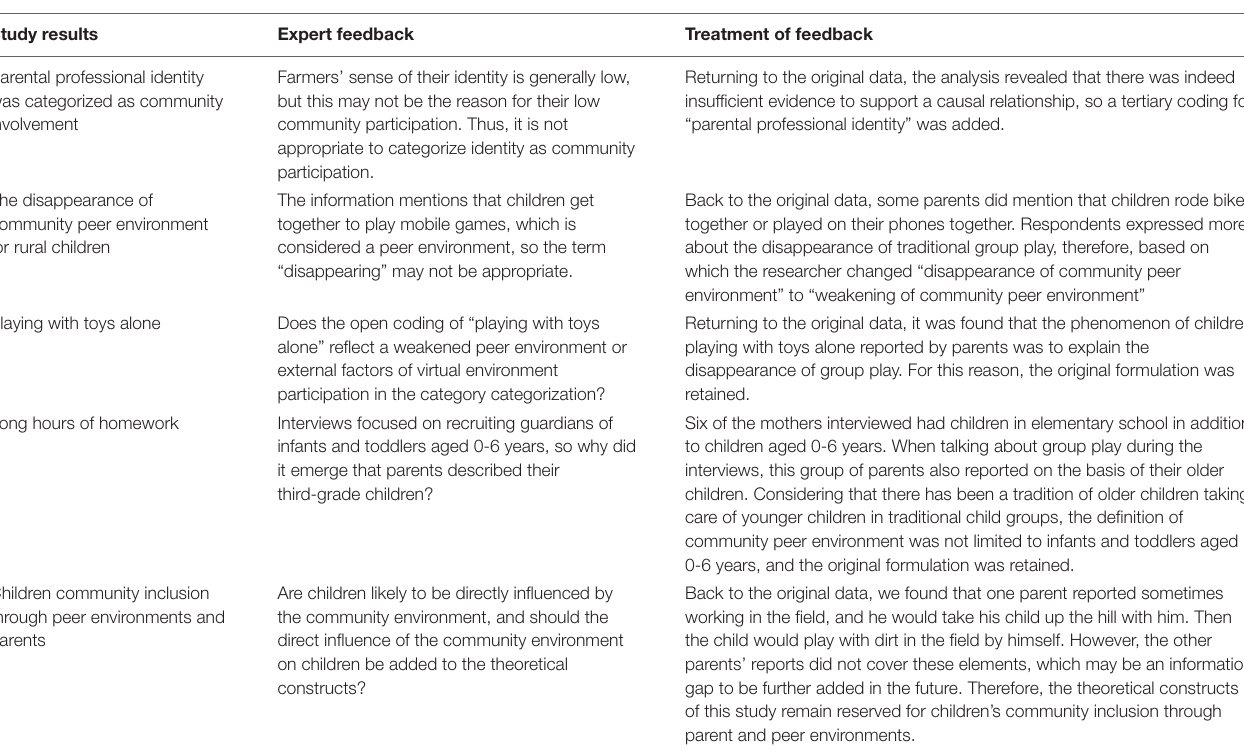
TABLE 3 | Feedback from experts and the treatment of